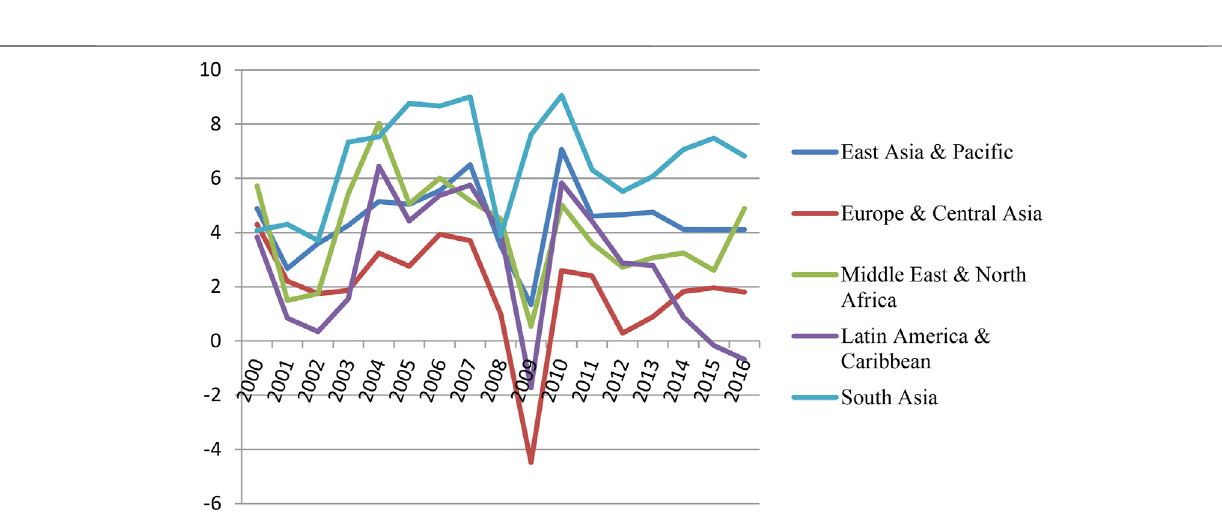
Frontiers in Environmental Science |